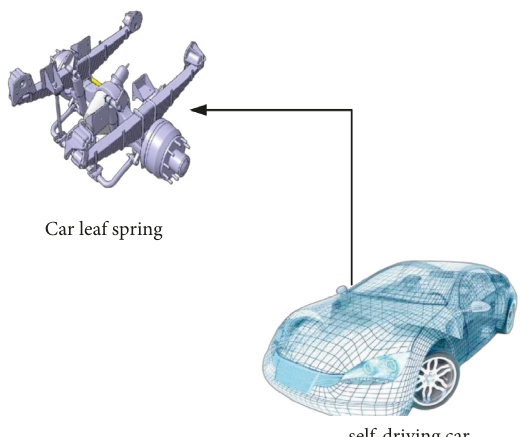
Figure 1: Application of variable section automotive leaf